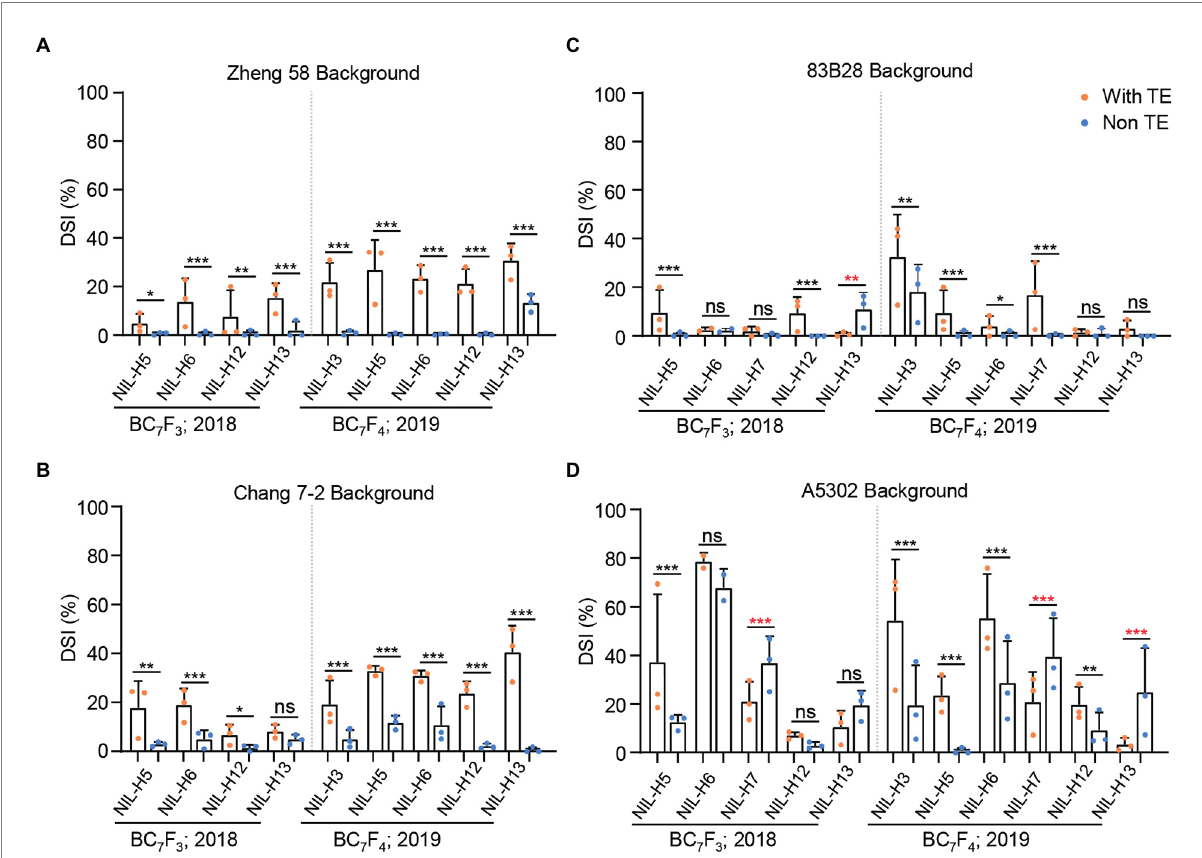
FIGURE 1 DSI of 22 NILs in four different backgrounds in 2018–2019 (Beijing). Five pairs of NILs include with TE ZmCCT homozygotes, and non-TE ZmCCT homozygotes in Zheng 58 (A) , Chang 7–2 (B) , 83B28 (C) , and A5302 (D) background were investigated for DSI. NILs include with TE ZmCCT homozygotes: H1/H1 , and non-TE ZmCCT homozygotes: H3/H3 , H5/H5 , H6/H6 , H7/H7 , H12/H12, or H13/H13 in different background were investigated for DSI. Values are mean ± standard deviation (s.d.). Asterisks indicate significant differences between H1/H1 plants and the other genotypes (two-tailed paired Student’s t-test , * p < 0.05, ** p < 0.01, *** p < 0.001, ns, not